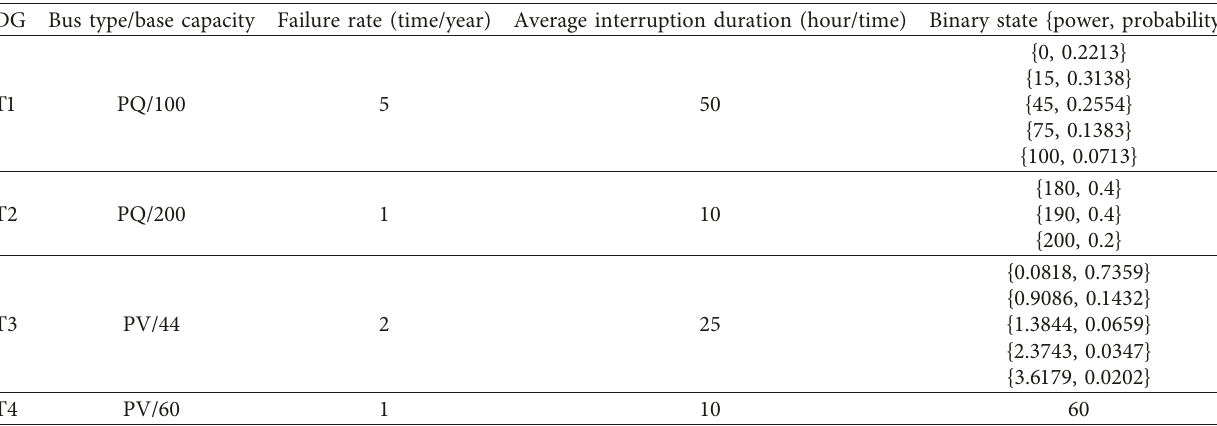
Table 4: Informations for different DG units.